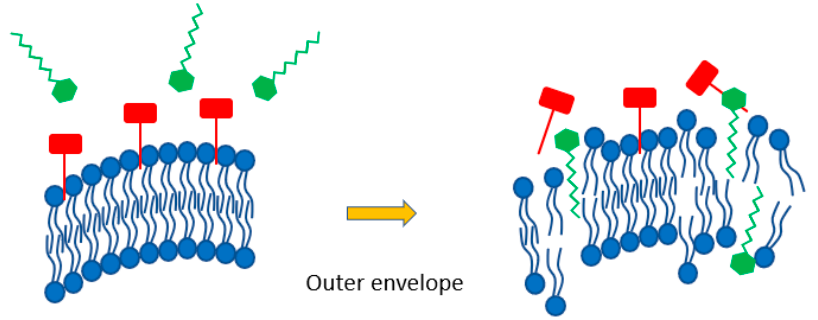
Figure 2. Schematic indicating benzylated boronium salt (green) disrupting outer viral envelope phospholipids (blue) causing a release of INFA hemagglutinin glycoproteins (red) that are required for host cell attachment.